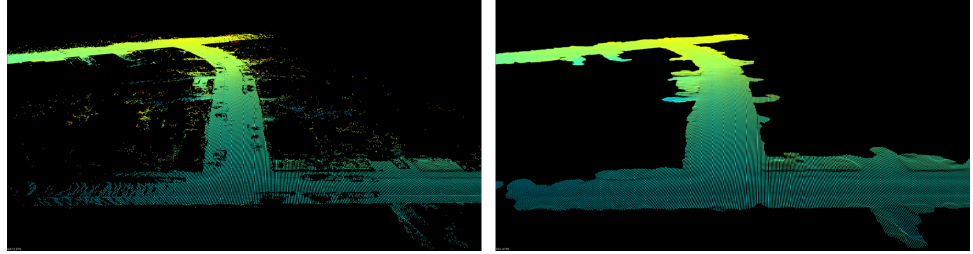
Figure 3. The input and output of the proposed terrain modeling approach. Points are colored according to the height